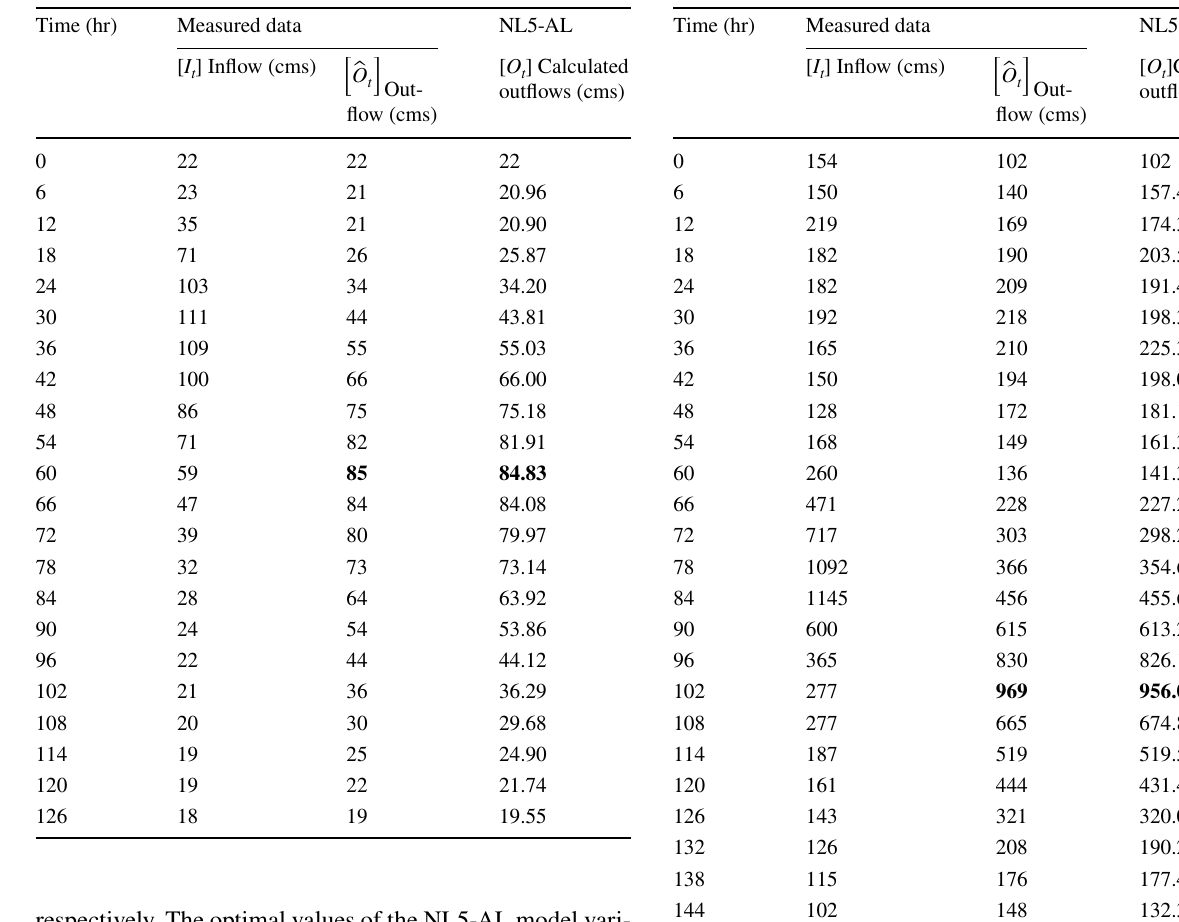
Table 2 Results of the second example (Wye River